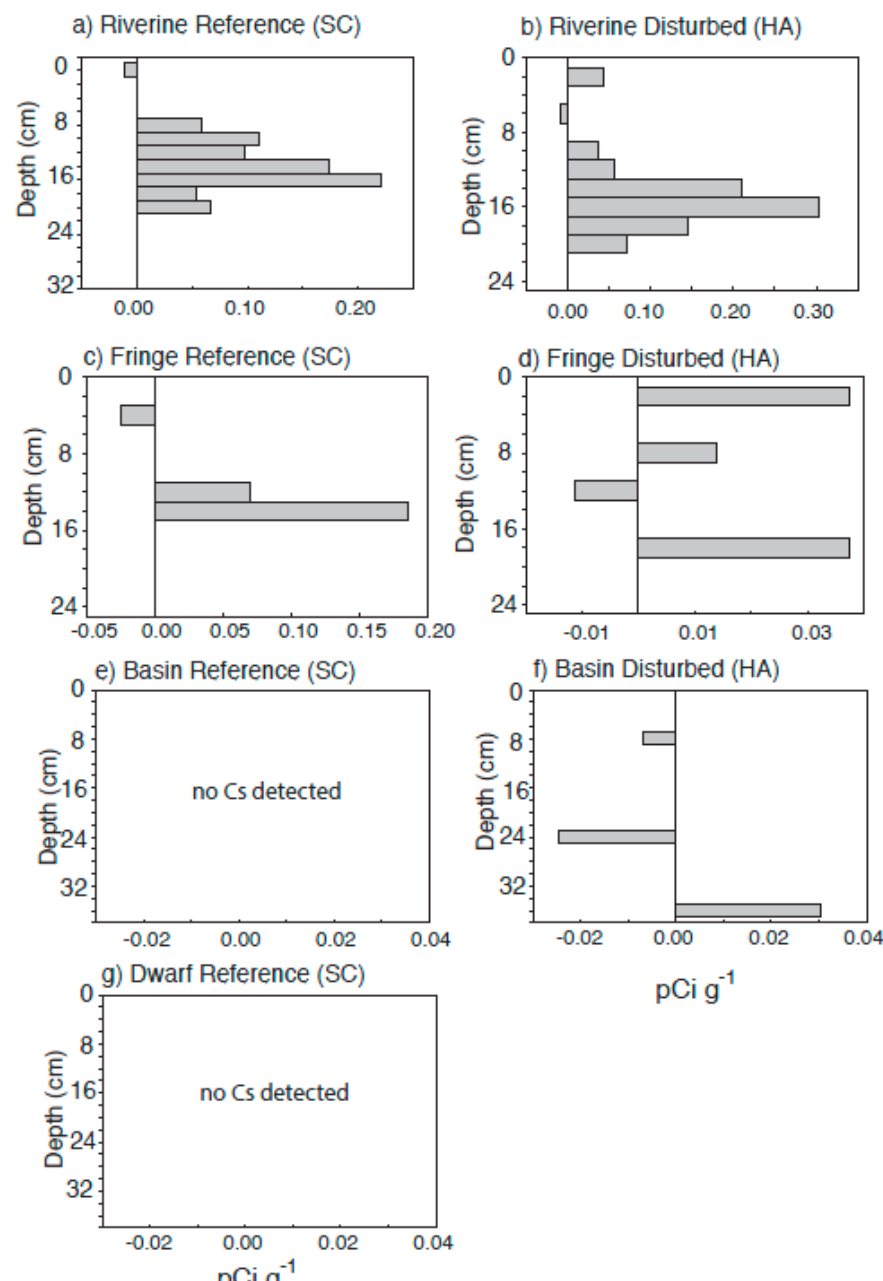
be 1.68 and 1.58 mm ¨ year ´ 1 in the basin mangroves, 2.28 and 2.23 mm ¨ year ´ 1 in the fringe mangroves, and 5.43 and 3.04 mm ¨ year ´ 1 in the riverine mangroves, for the reference (SC) and disturbed (HA) creeks, respectively. Sedimentation rates were 1.41 mm ¨ year ´ 1 in the dwarf mangroves that were found only in the reference creek. Forests 2016 , 7 , 116